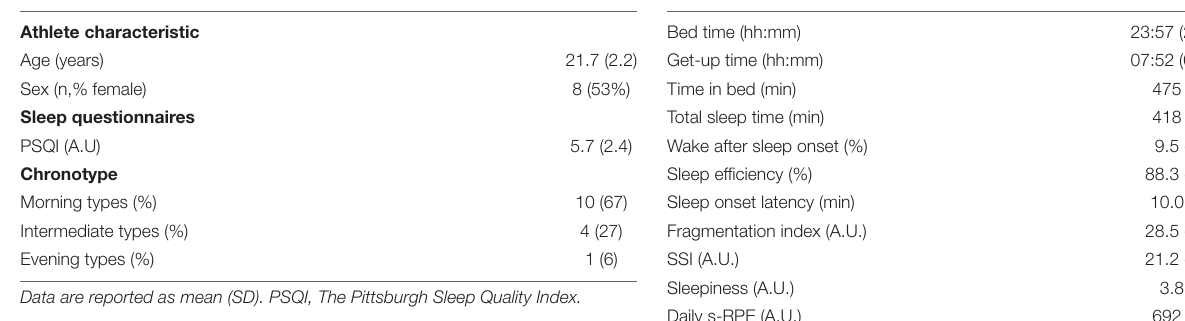
TABLE 1 | Participants’ characteristics and general sleep measures. TABLE 2 | Overview of the daily sleep variables and training